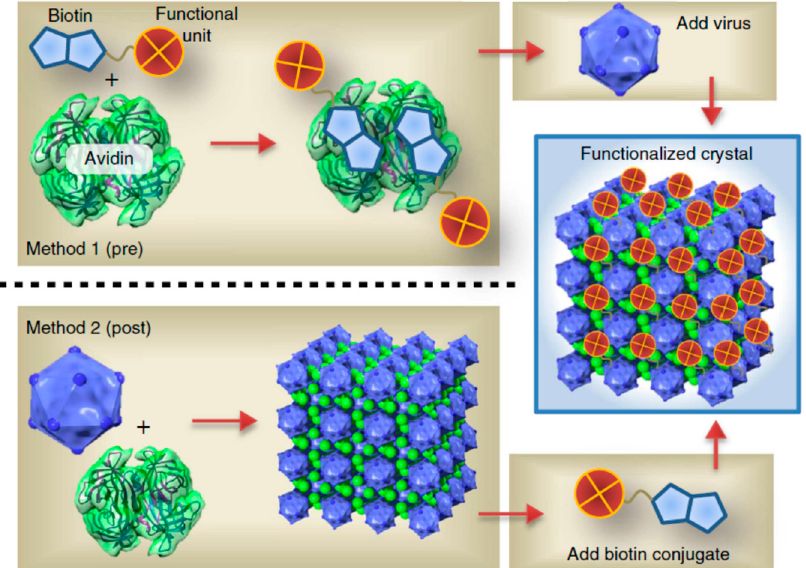
Figure 6. The avidin–biotin-binding-mediated self-assembly of a protein cage to three-dimensional (3D) functional crystals. Reprinted with permission from [95]. Copyright 2014 Macmillan Publishers Limited.